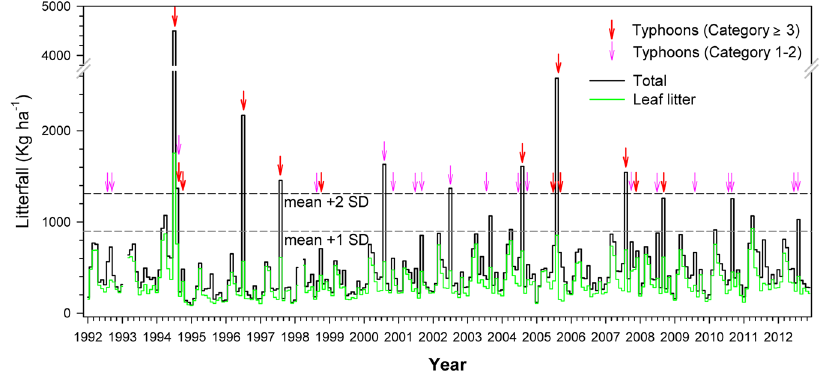
Figure 3. Monthly litterfall during 1992–2012 with highlights of minor and major peaks and typhoons of different intensity categories based on Saffir-Simpson scale. Minor peaks and major peaks refer to monthly total litterfall greater than long-term monthly mean (490 kg ha − 1 ) plus one standard deviation (410 kg ha − 1 ) and two standard